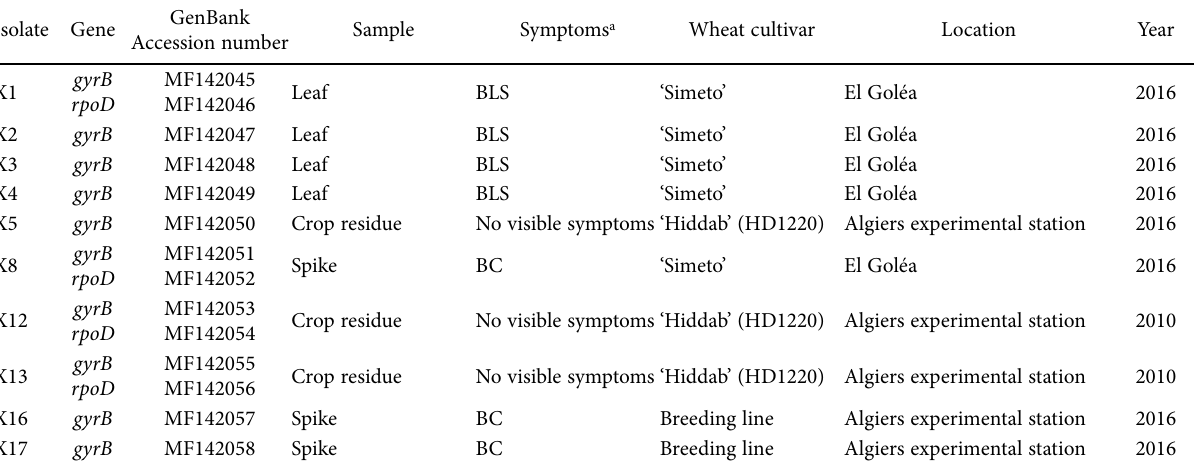
a BLS = bacterial leaf streak, BC = black